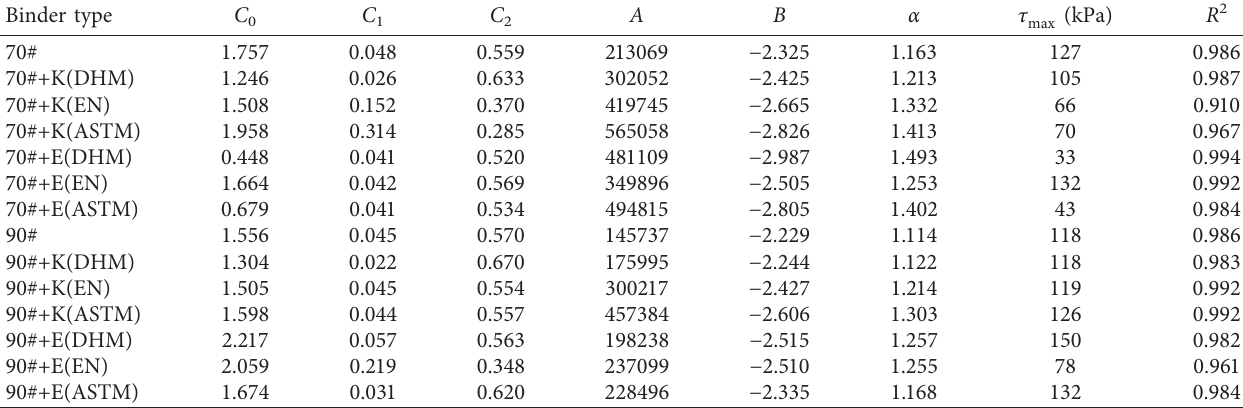
Figure 9: J nr, diff value results for the emulsified asphalt residues. Table 3: VECD analysis parameter results of the LAS test for the emulsified asphalt